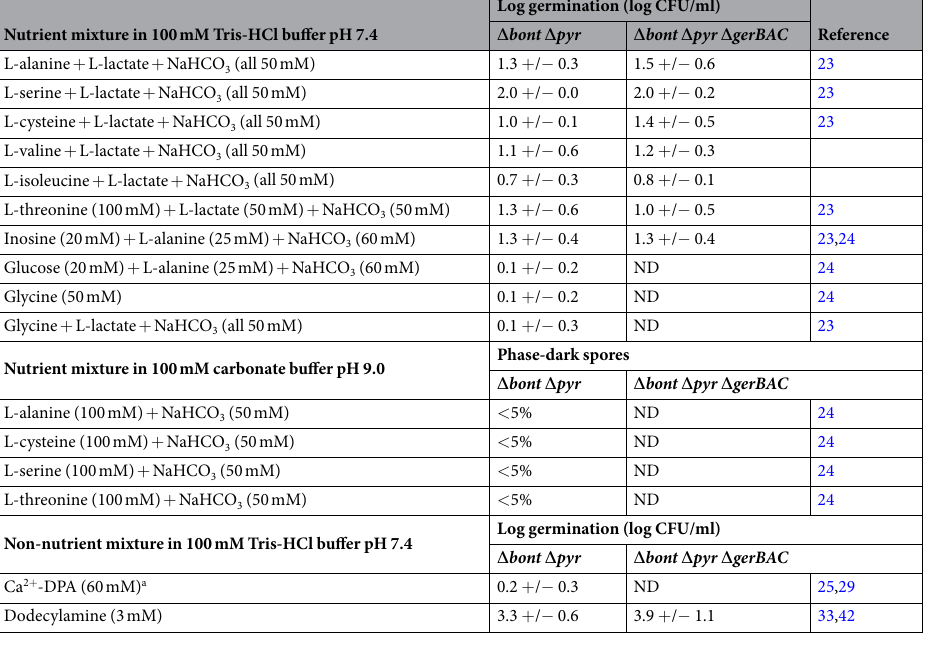
Table 2. Spore germination of NCTC 11219 strains after 4 h at 30 °C in different germinant mixtures. The degree of germination was determined by plate counting heated spore suspensions (65 °C/10 min), except for the treatments in carbonate buffer at pH 9.0, for which germination was evaluated by phase-contrast microscopy. Data for L-alanine/L-lactate/NaHCO 3 are from Fig. 1. (ND: not determined). Last column refers to studies in which mixtures were identified as gIICb germinant. a Ca 2 + -DPA at 20, 30 and 50 mM, germination levels were 0.3 + / − 0.2, 0.1 + / − 0.3 and 0.2 + / − 0.1 log,